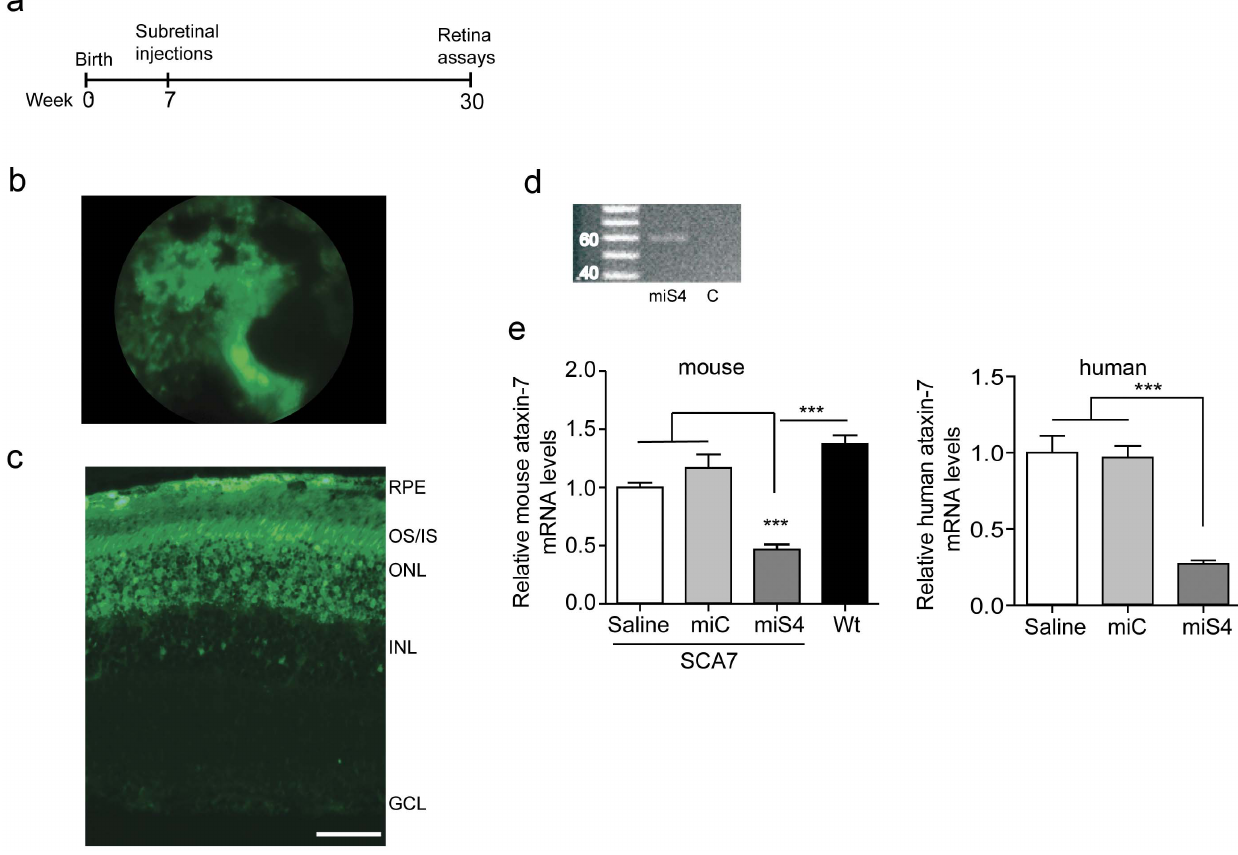
Figure 2. Sustained suppression of ataxin-7 expression. (a) Experimental scheme. (b) eGFP fluorescence as observed by funduscopy. (c) eGFP fluorescence indicating transduction of the RPE, photoreceptors, outer nuclear layer and few inner nuclear layer cells in the SCA7 retina at 30 weeks. (d) miS4 expression validated by stem-loop PCR in retinal extracts (n=3). miC was used as the negative control. (e) Relative levels of mouse (left panel) or human (right panel) ataxin-7 mRNA levels. Results are represented as mean 6 SEM (n=3 per group), *** p , 0.001.